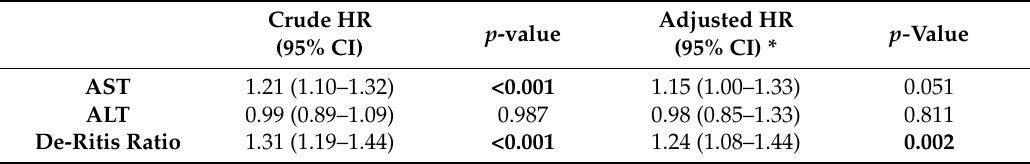
Table 3. Unadjusted and adjusted effects on cardiovascular